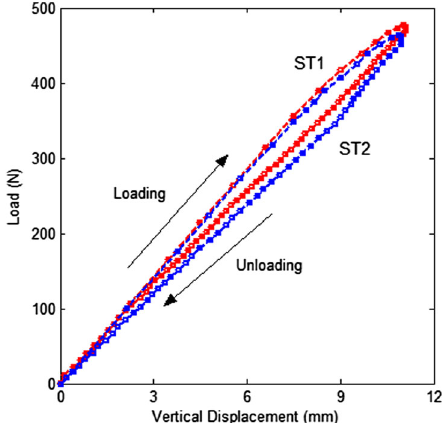
Fig. 9 Variations in the displacements at the bottom flange of the beam at the